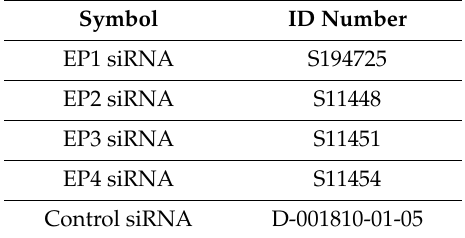
Table 2. siRNA Name and siRNA ID number in knockdown